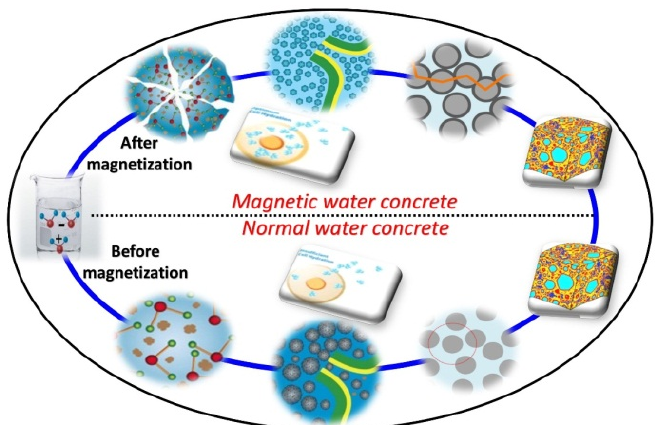
Figure 14. Mechanism of NWC and MWC.